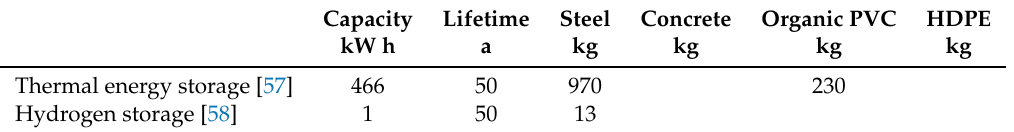
Table A5. Capacity, lifetime and material data for storages.